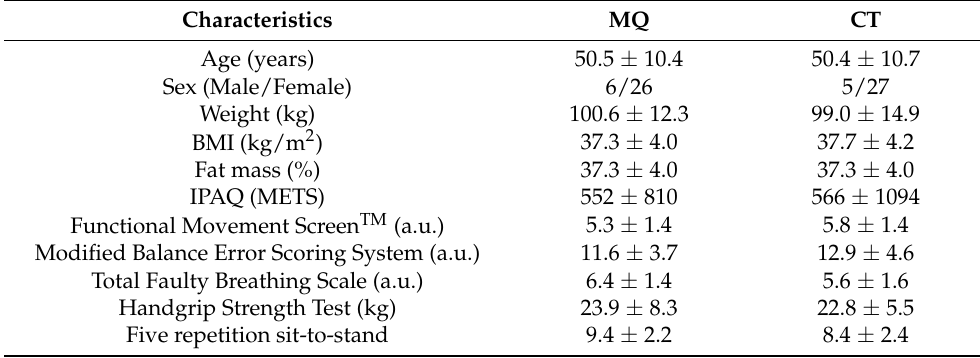
Table 2. Baseline characteristics highlighted by MQ and CT